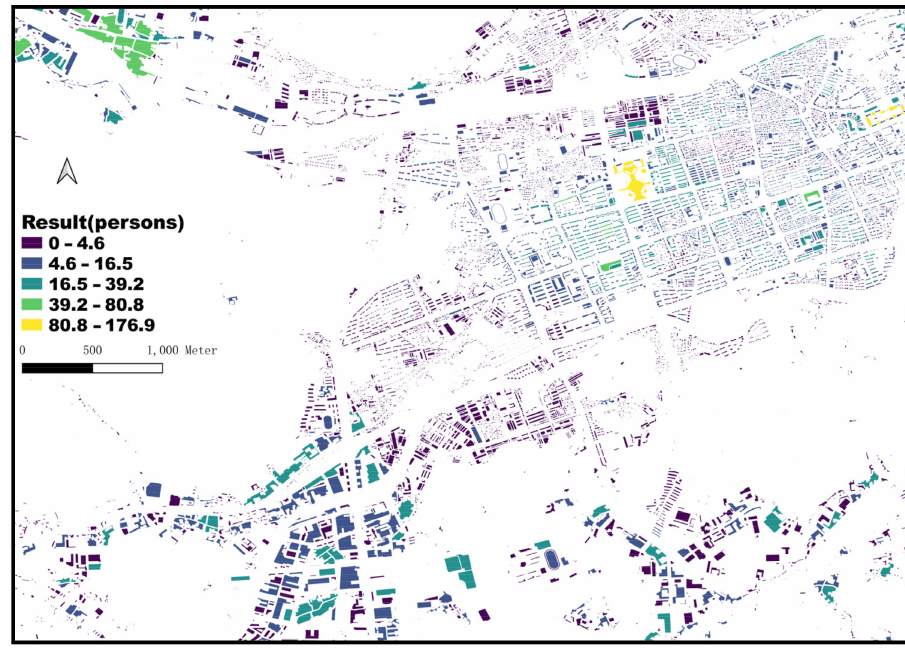
Figure 5. Results of the RF